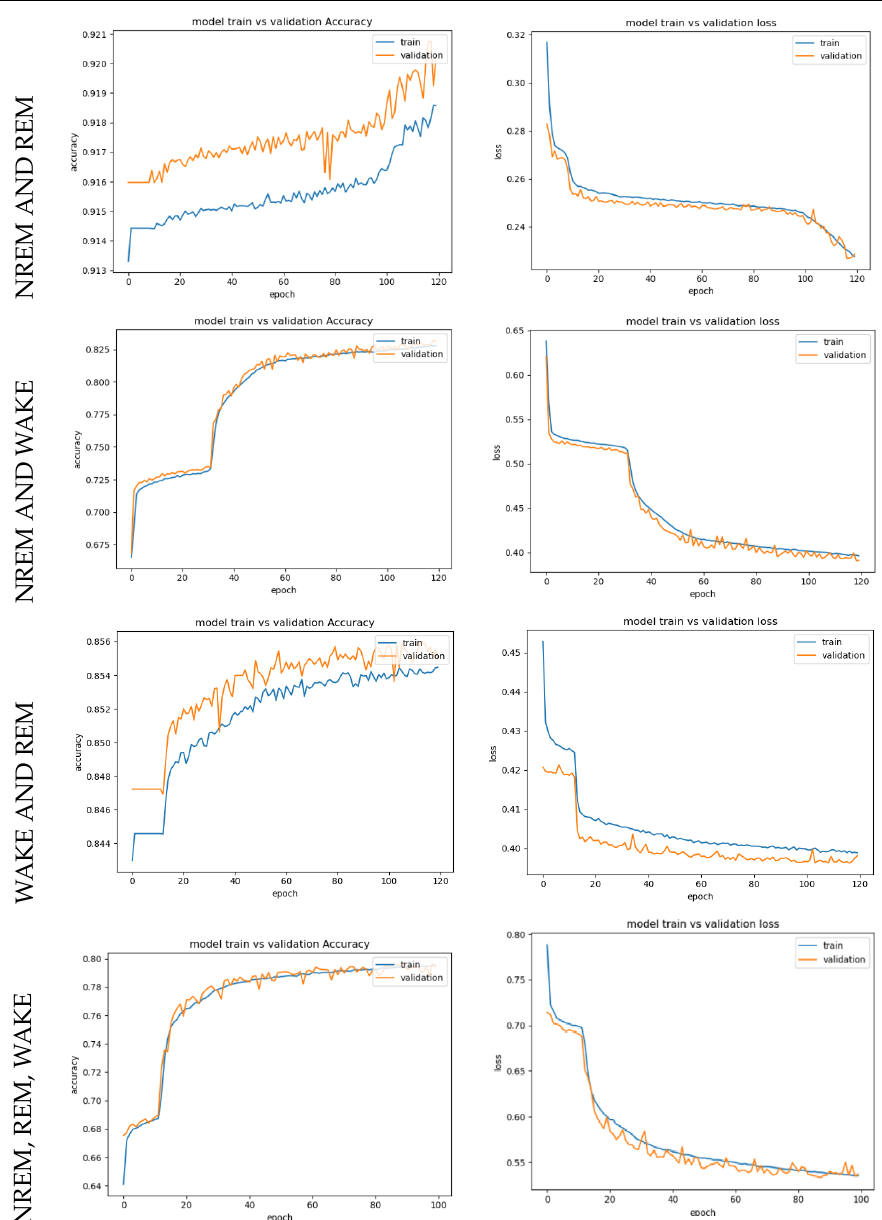
Table 7. Validation loss and accuracy for a single FC